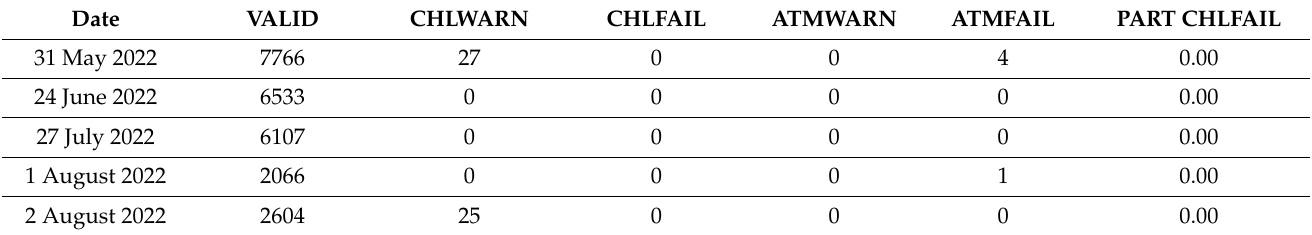
Table 5. The proportion of pixels with CHLFAIL flags based on ac-8 results for S-3B